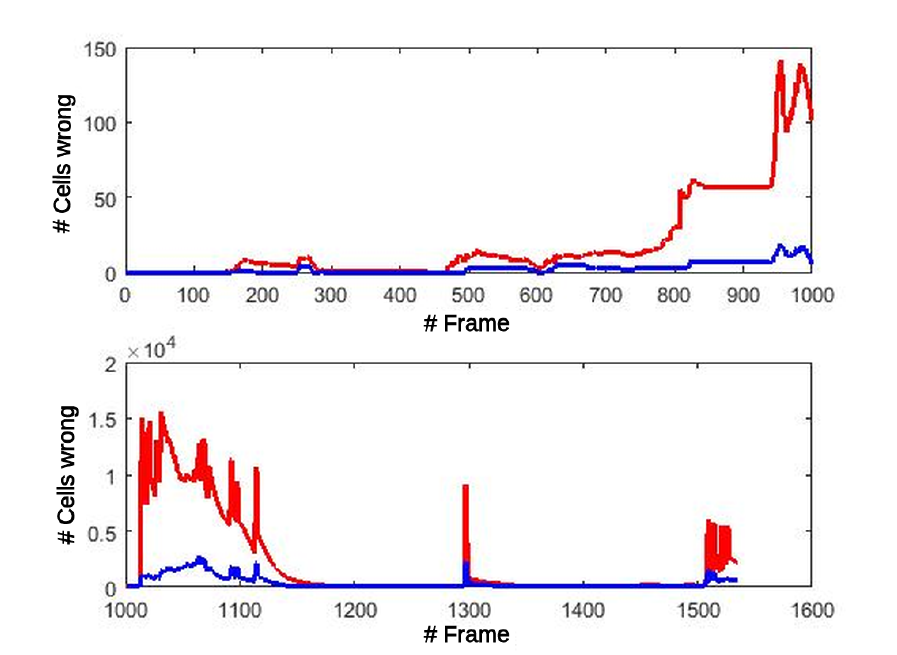
Figure 11. GPGPU errors after Prior stage. Red: counters of non-occupied cells (Fc). Blue: counters of occupied cells